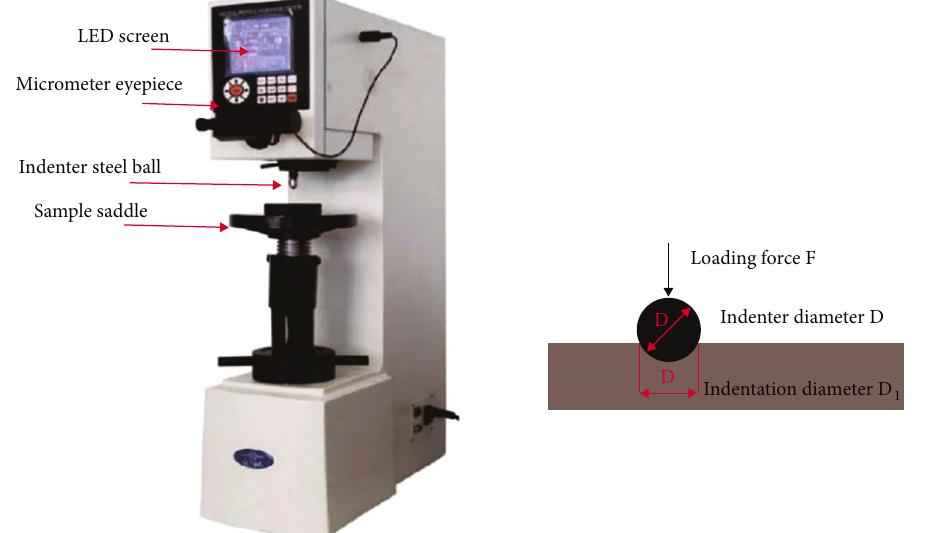
Figure 1: Brinell hardness tester and test